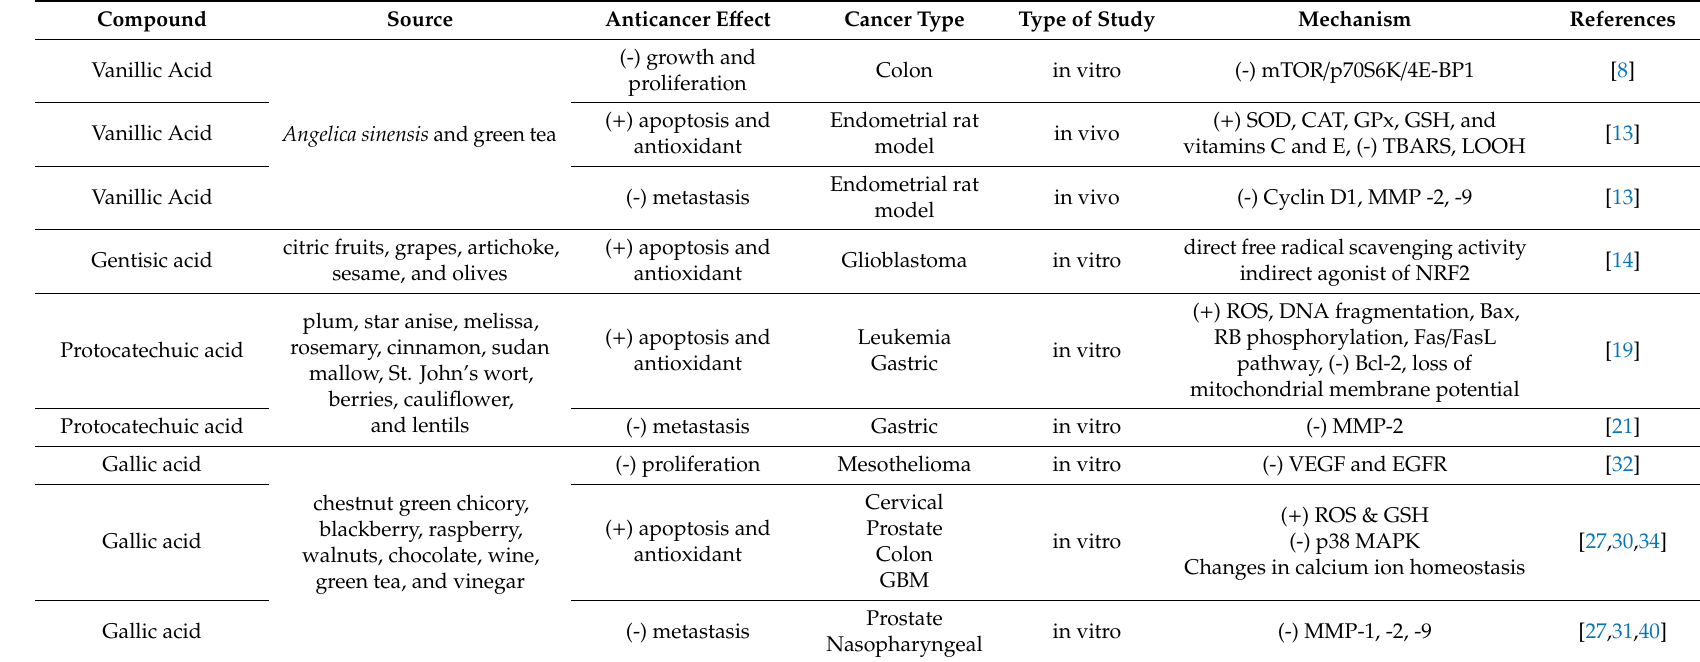
Table 1. Main anticancer pathways of phenolic